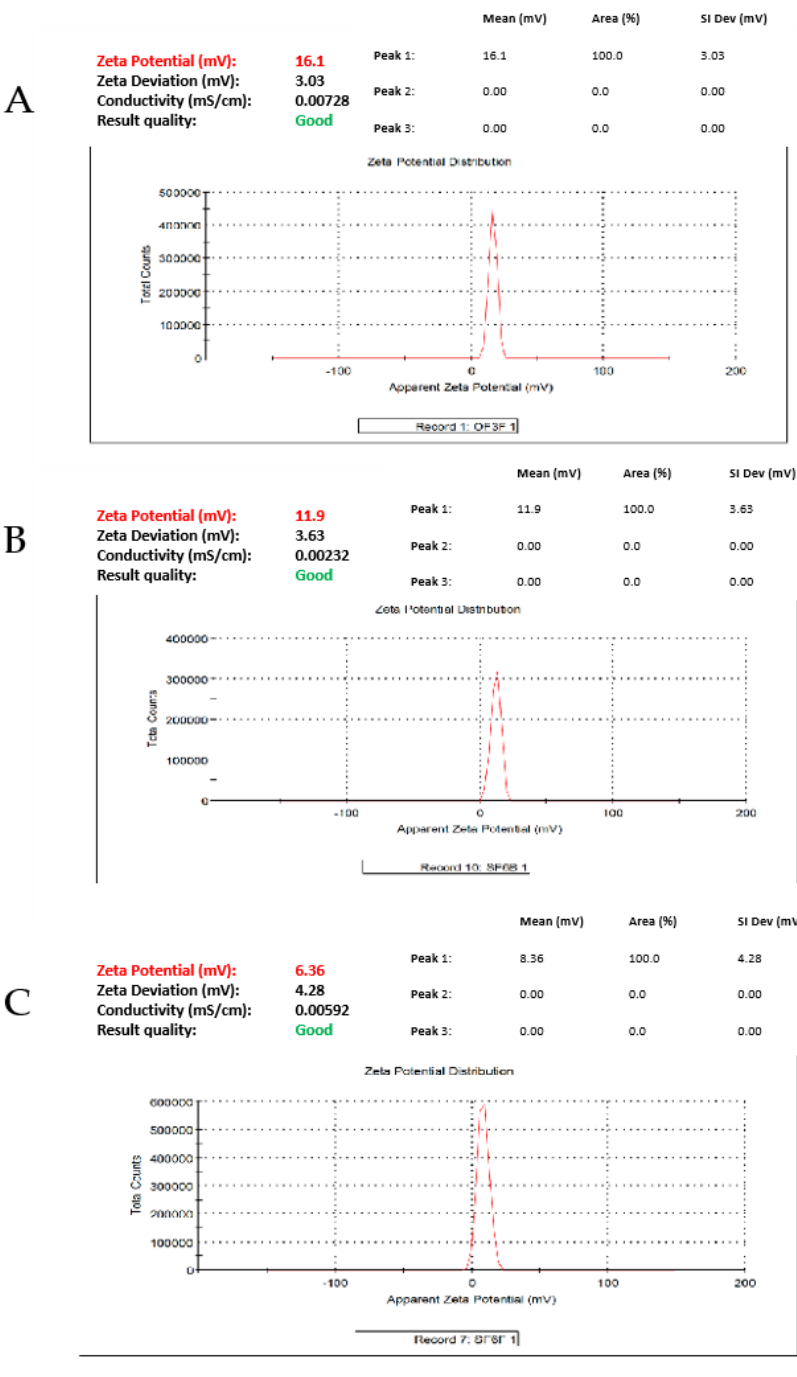
Figure 3. Zeta potential distribution of the optimised TAM-NE: ( A ) for NE1, ( B ) for NE9, and ( C ) for